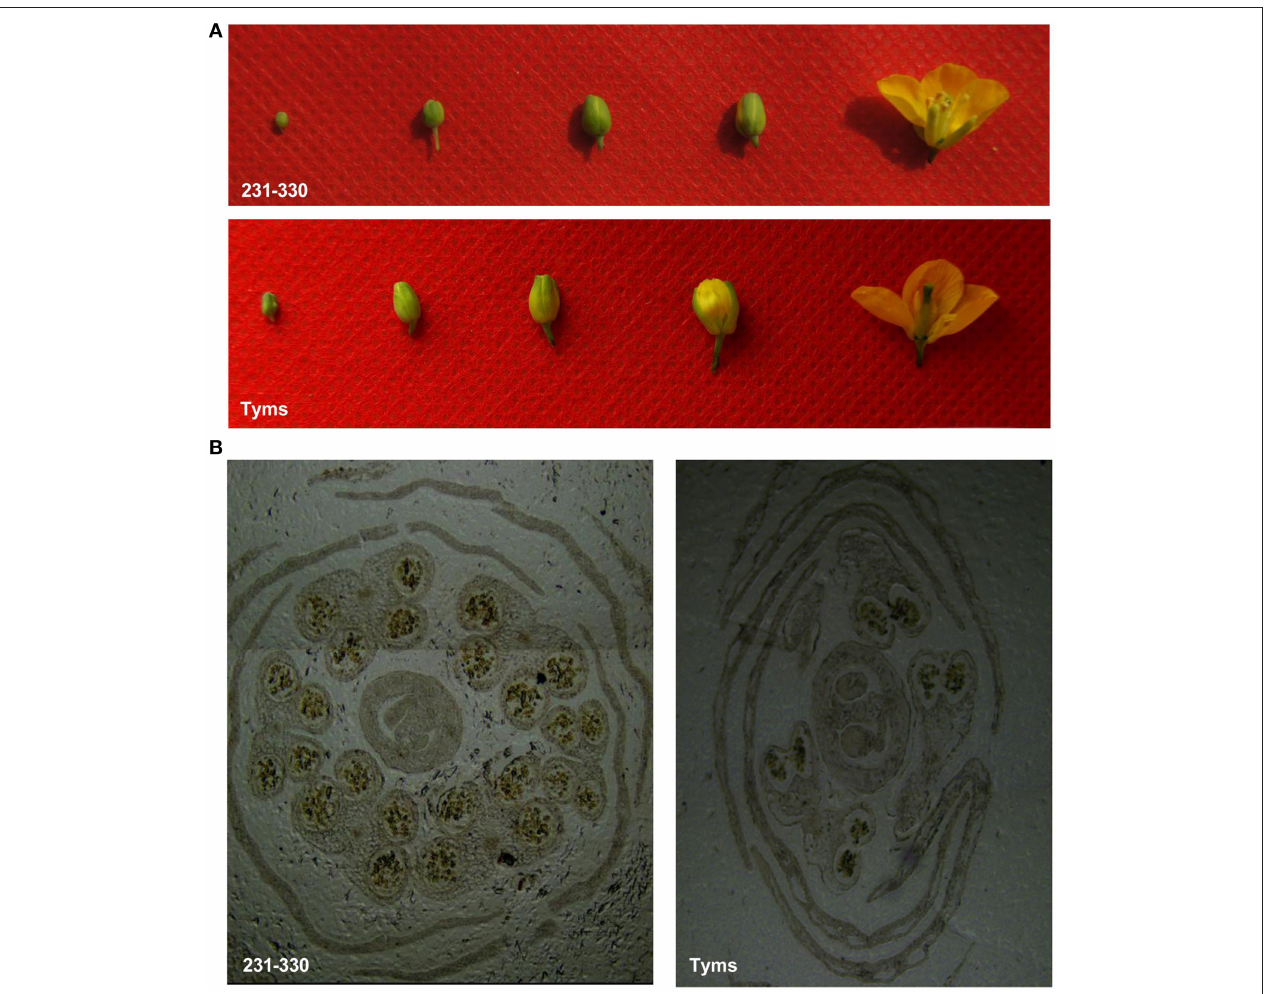
FIGURE 1 | The buds and flowers of the Ogura-CMS (Tyms) and maintainer (231-330) lines. (A) the buds of four developmental stages and the flower that were sampled for this study. (B) microscopy of the buds showing the well-developed pollen sacs in 231–330 and incomplete development in Tyms.